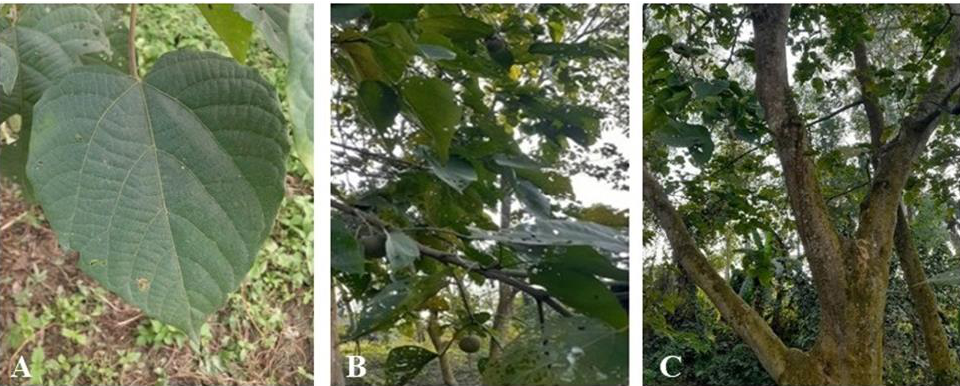
Figure 1. T. nudiflora leaf ( A ), branch with fruit ( B ), and trunk ( C ).